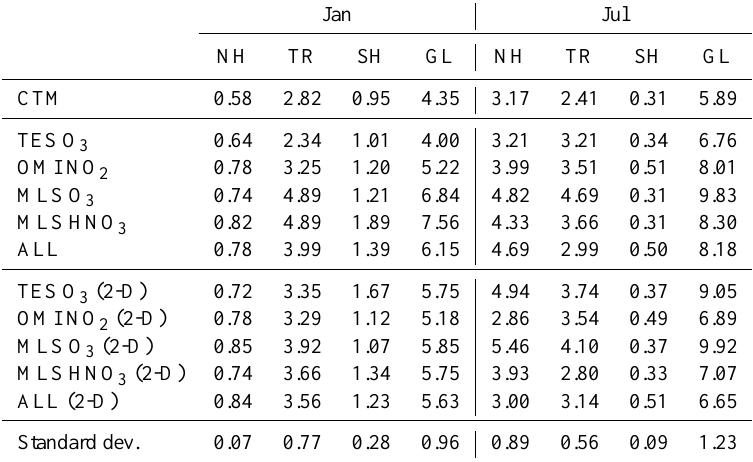
Table 4. The monthly LNO x sources (in TgN) for the Northern Hemisphere (NH, 20–90 ◦ N), the tropics (TR, 20 ◦ S–20 ◦ N), the Southern MLS O 3 , and MLS HNO 3 observations, and from the assimilation of all the data sets. Also shown are results for data assimilation that optimize a height-independent LNO x source scale factor (2-D). Standard deviations obtained from all the data assimilation estimates are also